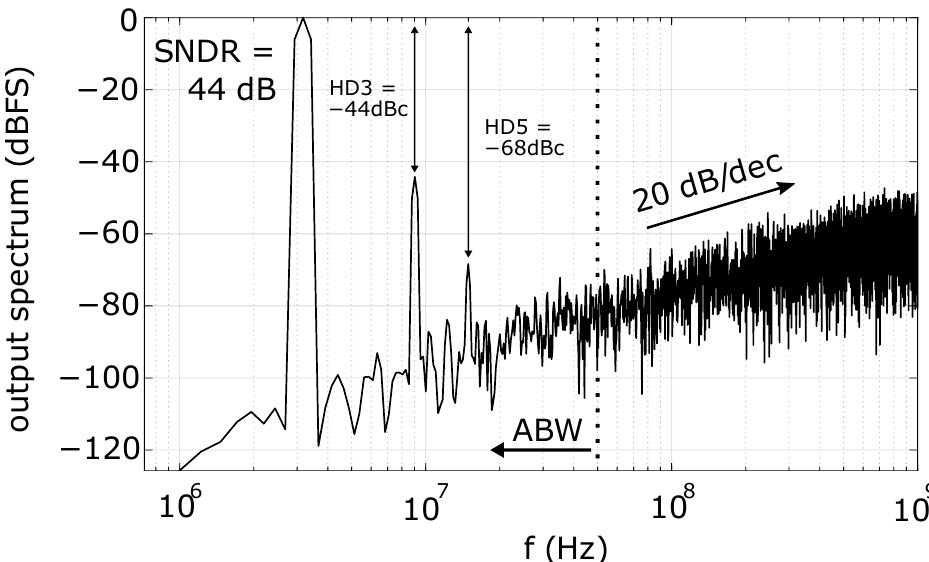
Figure 3. Distortion due to a nonlinear ring-oscillator in analog-to-digital conversion.